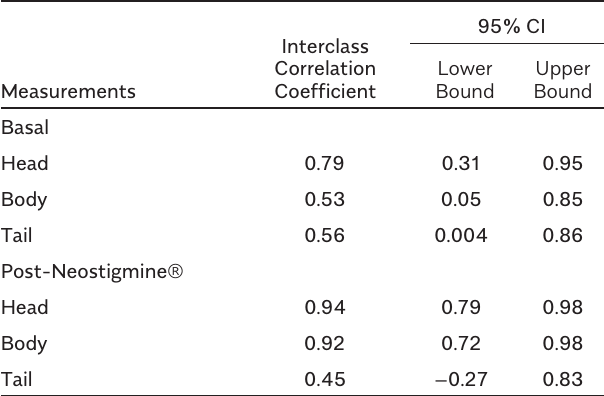
Table 2. Interclass Correlation Coefficient Between the 2 Radiologists’ Measurements of the Pancreatic Duct Diameter